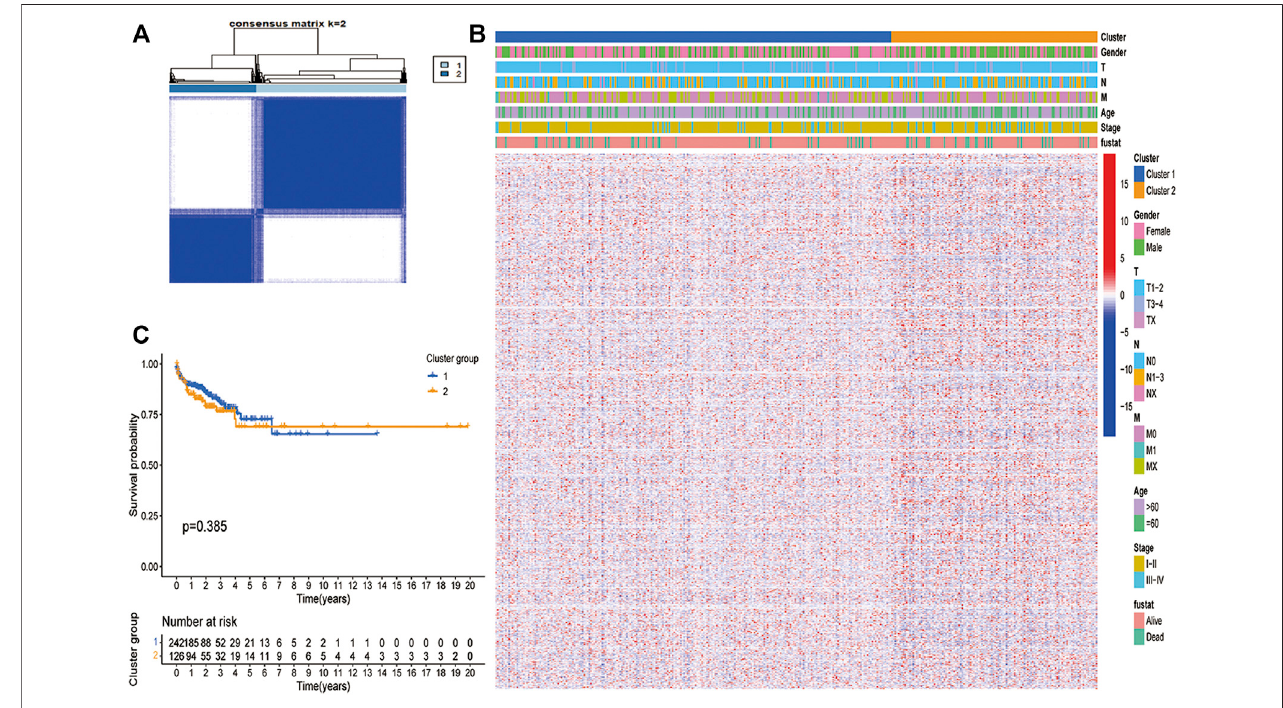
FIGURE 1 | Unsupervised clustering analysis in TCGA dataset. (A) The TCGA dataset were strati fi ed into two clusters based on the consensus matrix (k = 2). (B) Differences in clinicopathologic features and expression levels of differentially expressed PCDs between the two distinct clusters. (blue: low expression level; red: high expression level). (C) Survival curve analysis show no difference in Os between the two clusters ( p >